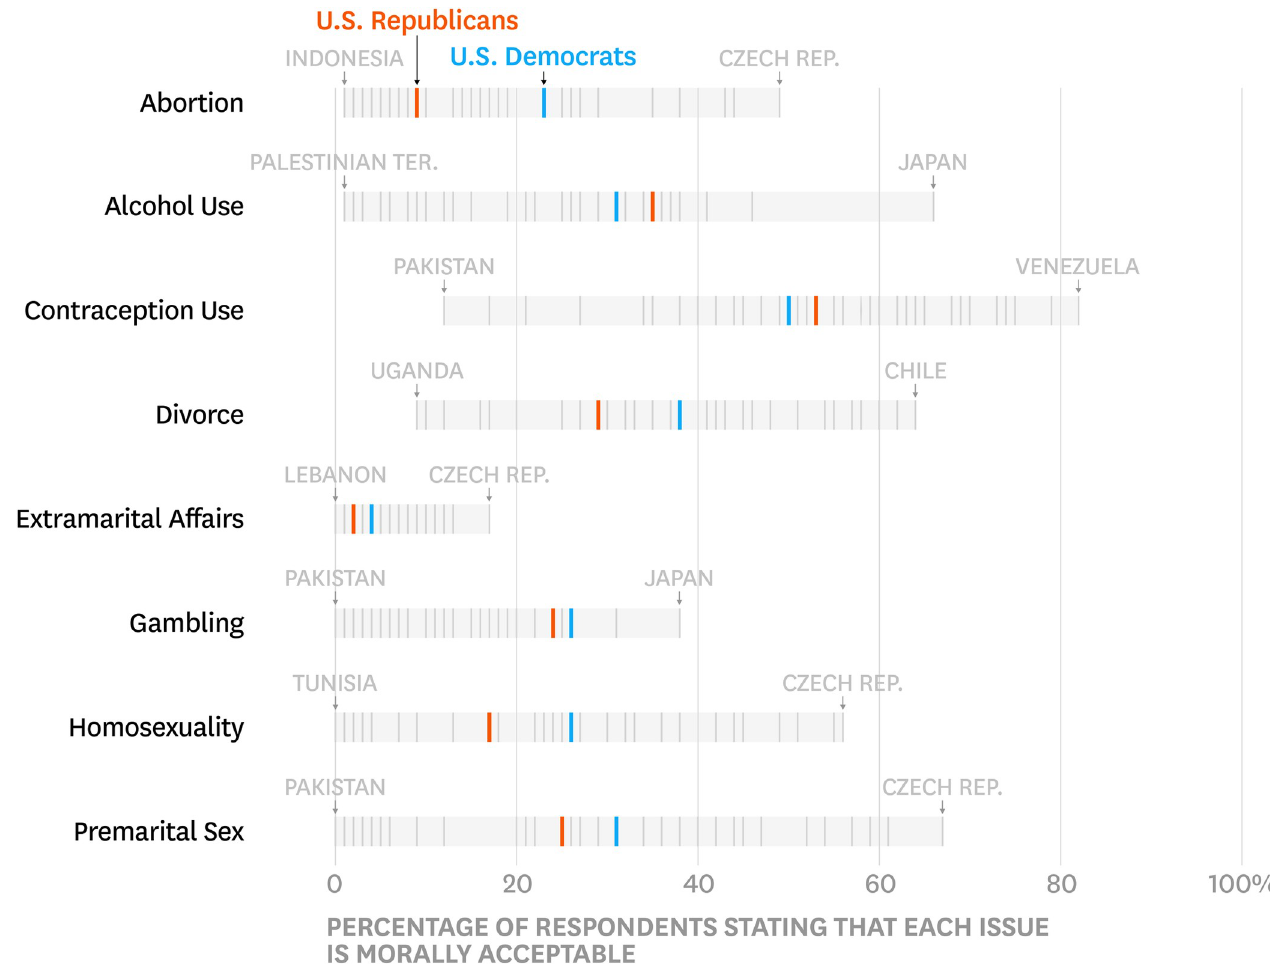
Fig 1. Moral issues: Democrats and republicans in global context.